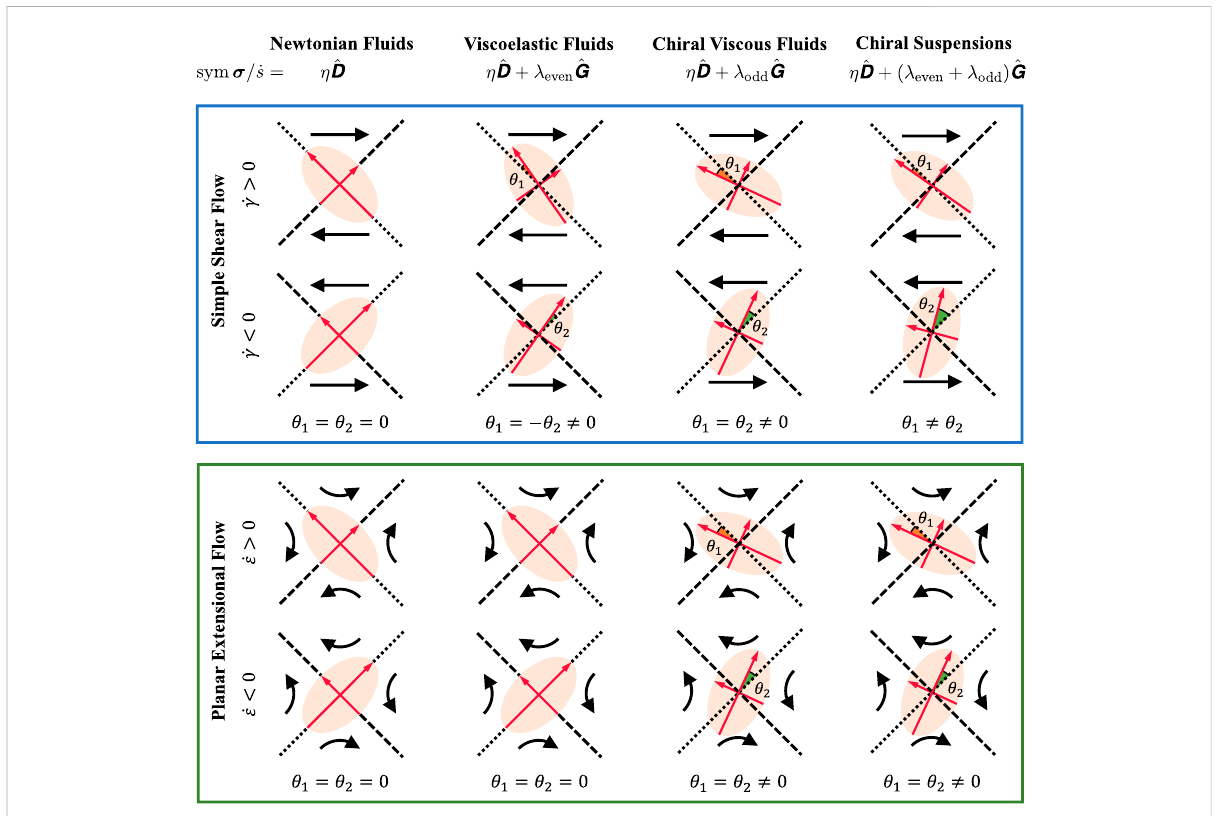
FIGURE 5 Schematics ofresponse stress ofdifferent fl uids insimple shear and planar extensional fl ows. Thered arrowsrepresent theprincipalaxes ofthe response stress in the fl ow plane, whereas the black arrows denote the direction of imposed strain. The symbols λ even and λ odd denote the even and odd components of non-dissipative response function λ . The subscripts 1 and 2 indicate the reorientation angles for the positive and negative shear or extensional rate,